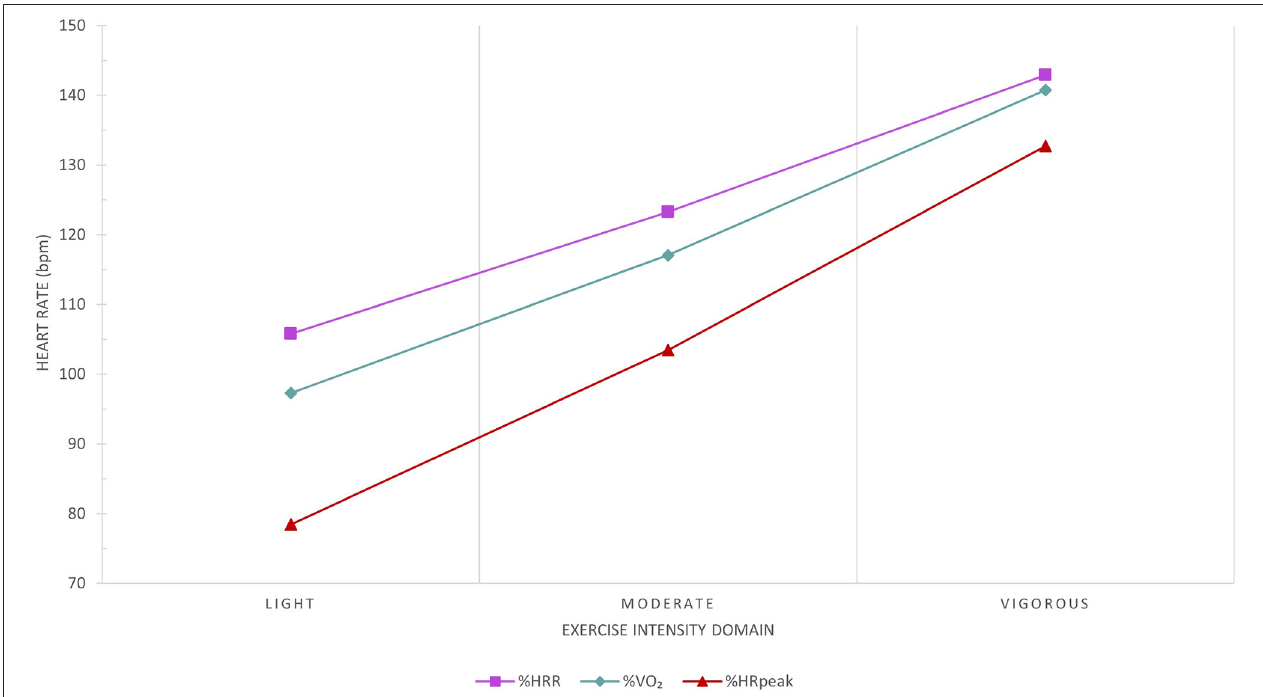
FIGURE 8 | Comparison between the percentage of peak heart rate (HR; [%HRpeak]) and percentage of HR reserve (%HRR) methods to the average reference HR recorded at the corresponding percentage of peak VO 2 (%VO 2 ) exercise intensity domain. The %HRpeak method significantly underestimates the reference exercise HR. The %HRR method results in clinically insignificant differences to the corresponding reference HR recorded in all exercise intensity domains based on %VO 2 and reflects metabolic load more accurately than the %HRpeak method. Data from 287 congenital heart disease patients at Royal Prince Alfred